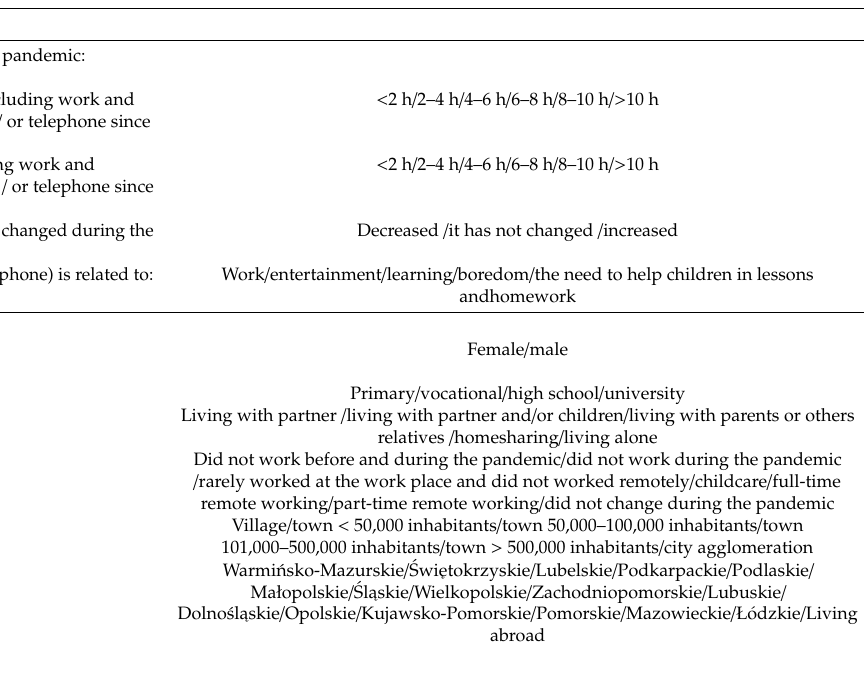
Question Answer Dietary Habits During COVID-19 the